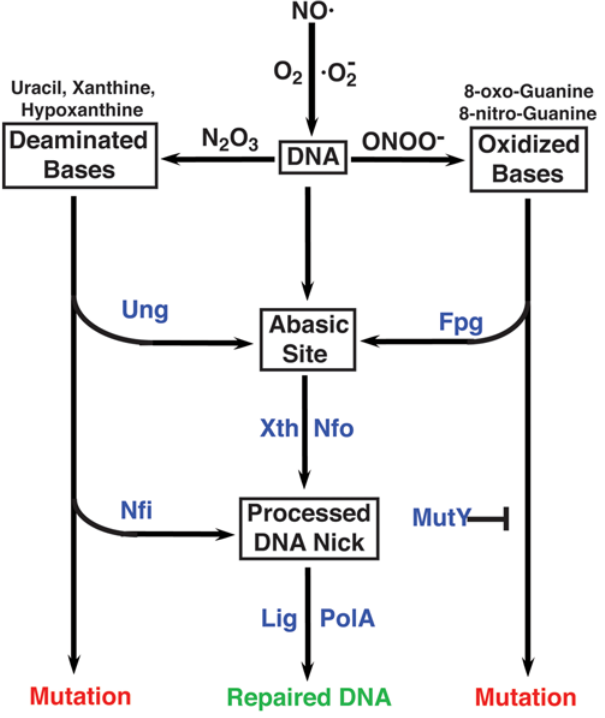
Figure 4. Conceptual representation of mutation avoidance by BER during nitrosative stress. NO ? can be oxidized to nitrous anhydride (N 2 O 3 ) and/or peroxynitrite (ONOO 2 ) depending in the presence or absence of superoxide. Nitrous anhydride and peroxynitrite mediate DNA base deamination and oxidation, respectively. The Ung repair pathway removes dU from DNA via an AP site, thereby avoiding the MUTATION pathway. Similarly, Fpg removes oxidized dG, limiting peroxynitrite-mediated hypermutation, but increased mutability in cells lacking Fpg can be ameliorated by MutY. NO ? -induced mutations can also be avoided by pathways that do not produce AP site intermediates (e.g., Nfi).